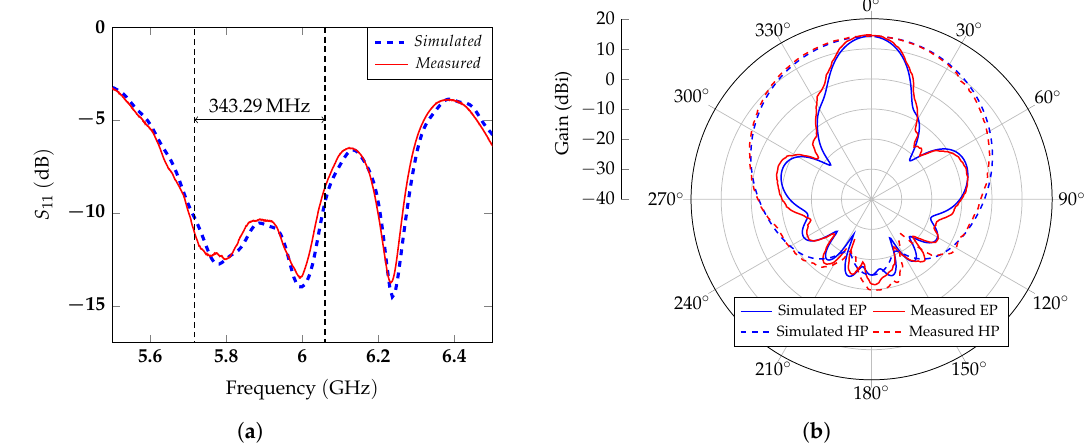
Figure 4. Simulated and measured ( a ) reflection coefficient and ( b ) radiation pattern at 5.8GHz in the Eand Hplanes (EP and HP).